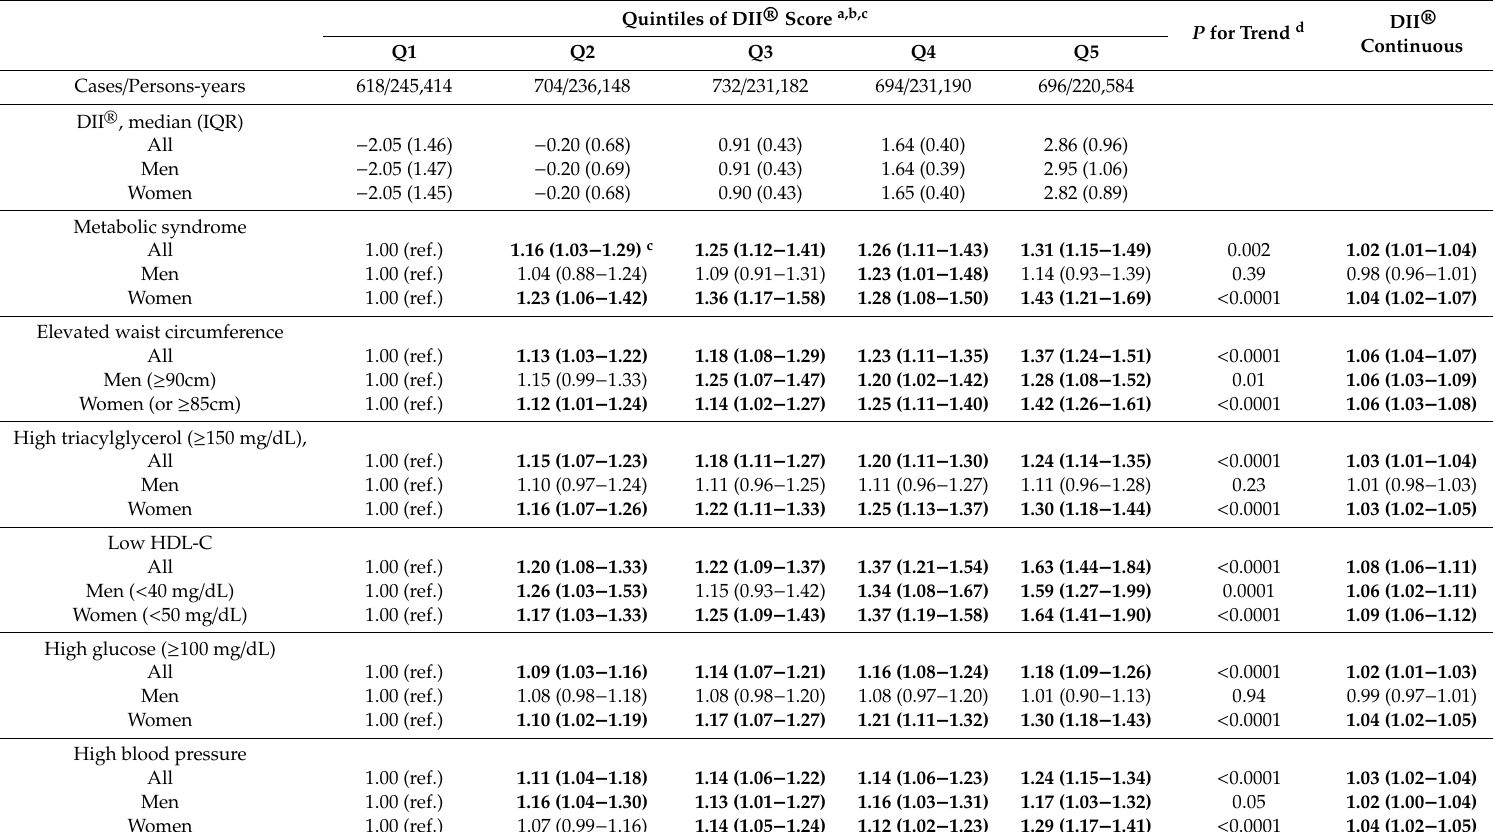
Table 2. Hazard ratios (HRs) and 95% confidence intervals (CIs) for risk metabolic syndrome and its components according to DII ® quintiles. Quintiles of DII ® Score